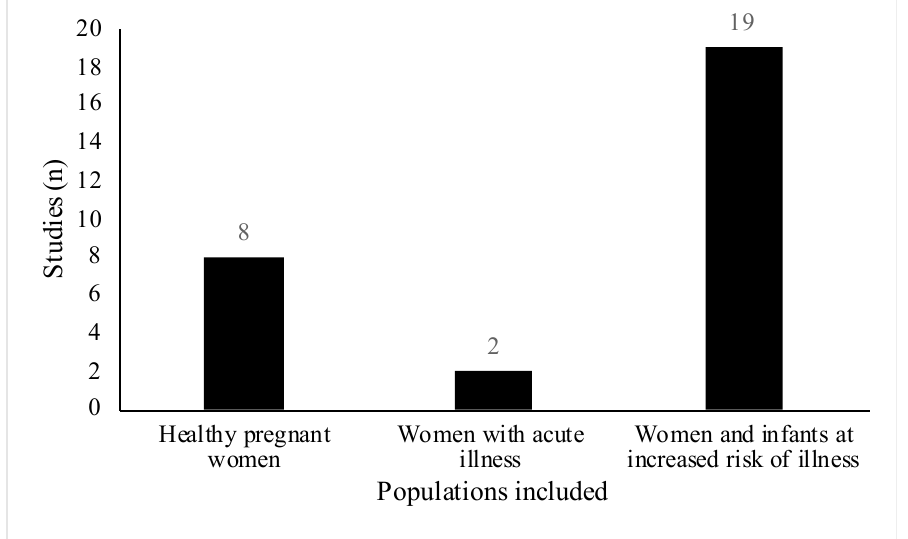
Figure 4. Distribution of healthy pregnant women compared with pregnant women and/or their infants at increased risk of or suffering from an illness in included studies ( n = 29). Of note, healthy pregnant women include women where studies do not mention any specific health conditions.